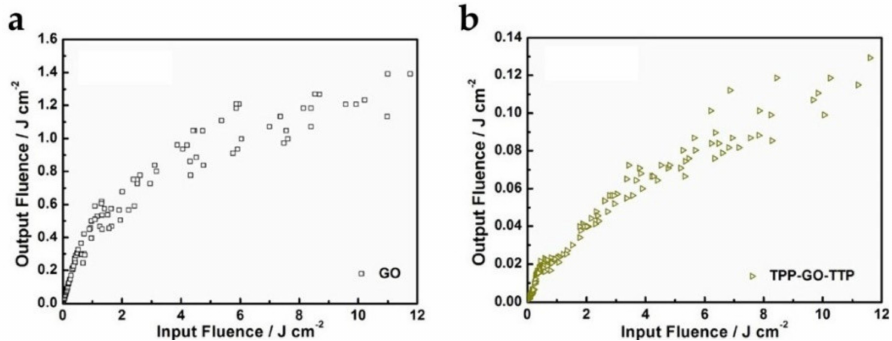
Figure 9. Optical limiting performances of ( a ) GO and ( b ) TPP-GO-TTP (Reproduced with permission from ref. [59]. Copyright 2020 Elsevier